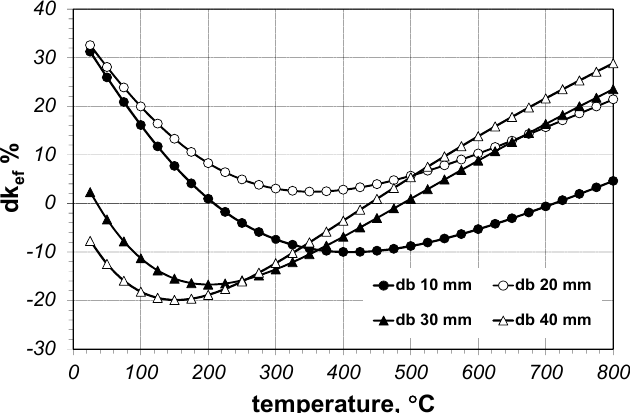
Figure 9. The results of calculations of the relative percentage difference dk ef between the full solution and the simplified solution.